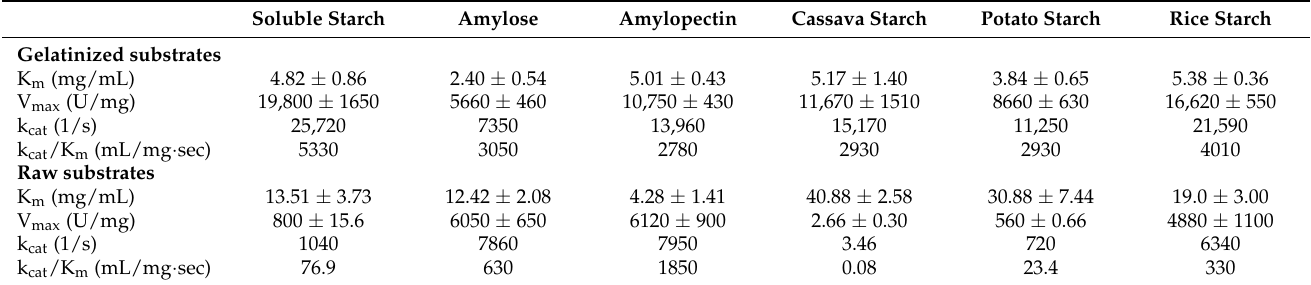
Table 2. K m and V max values of HL11Amy to different gelatinized and raw